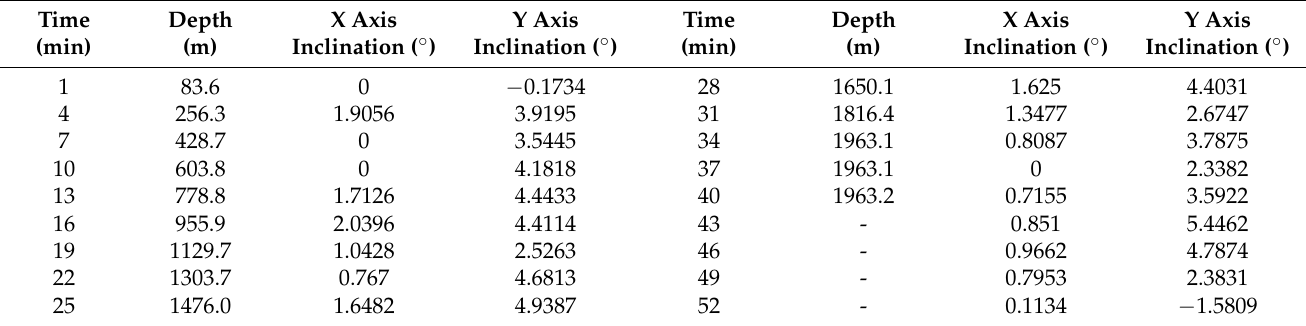
Table A4. Water entry time-movement inclination record